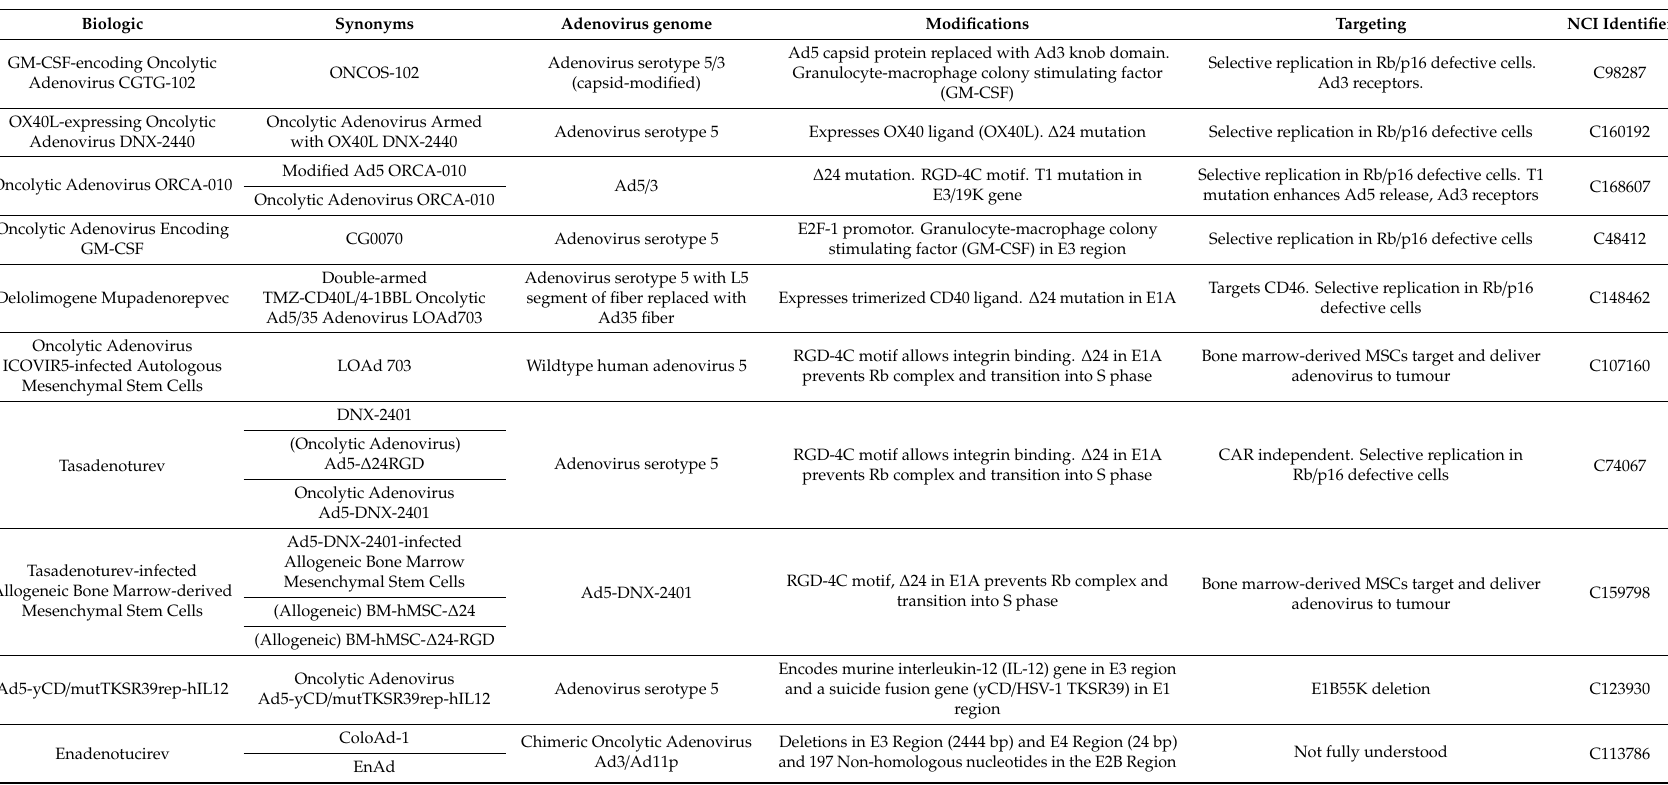
Table 1. A summary table of Ads in clinical trials, with their base genome, modifications and their target. Data obtained from https: // www.cancer.gov / (Accessed